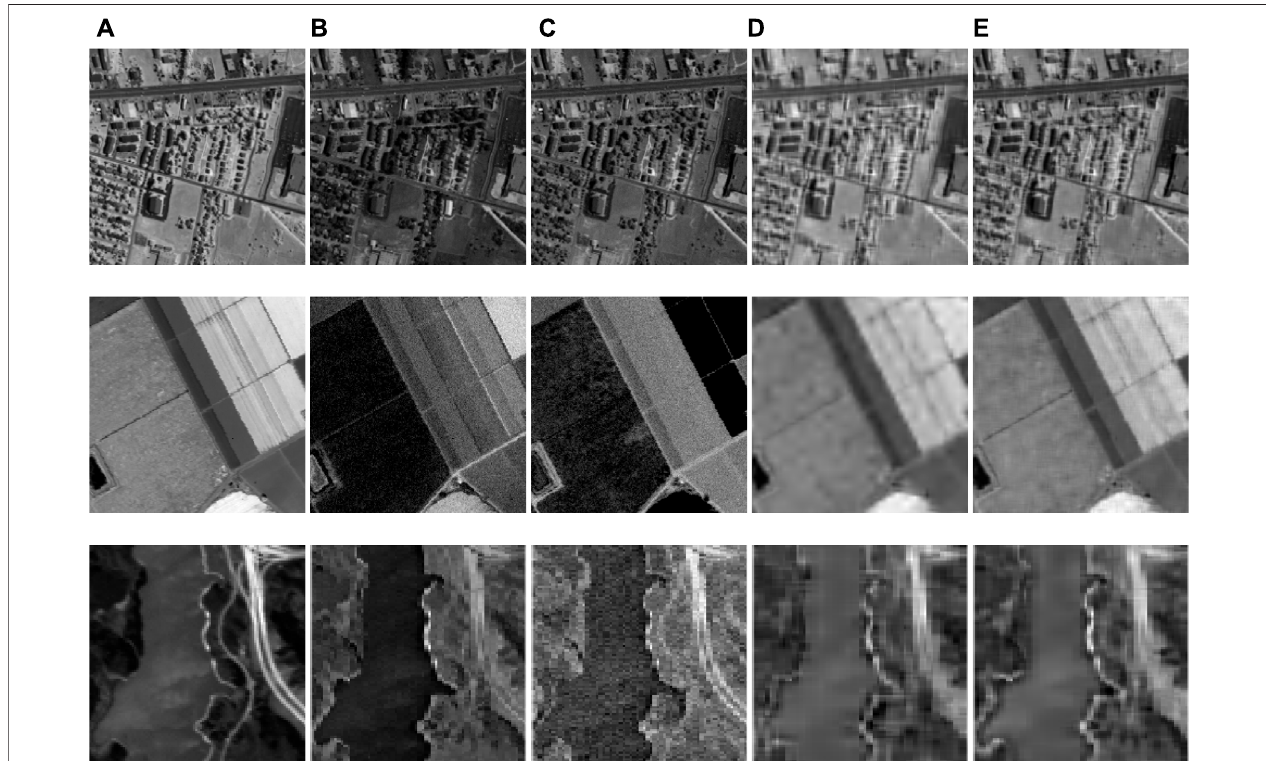
FIGURE 12 | Reconstruction using different methods: (from top to bottom) 110th band of image “ Urban, ” 55th band of image “ Salinas, ” and 10th band of image “ Jasper-Ridge. ” (A) Original band, (B) SSHBCS, (C) RLPHCS, (D) WTL-D, and (E) WTL-I. Results are shown at 5 % SR and 25 dB SNR.